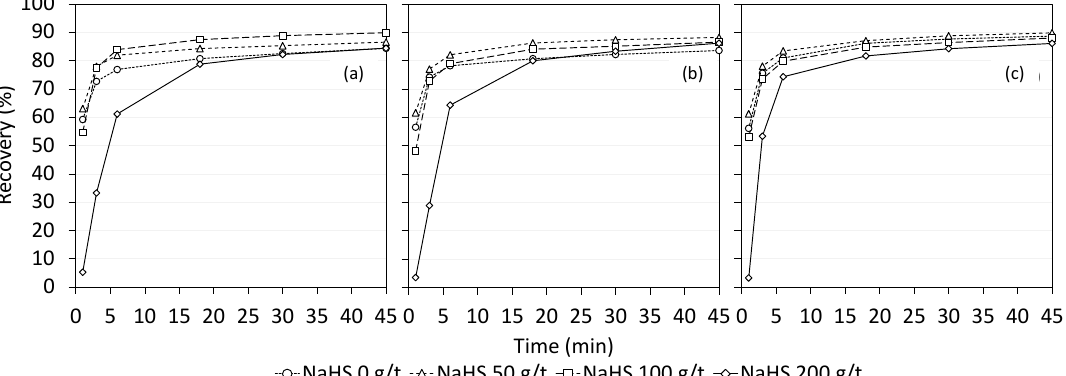
Figure 7. Bornite recoveries without NaHS and with NaHS dosages of 50 g/t, 100 g/t, and 200 g/t at ( a ) pH 8, ( b ) pH 9, and ( c ) pH 10.